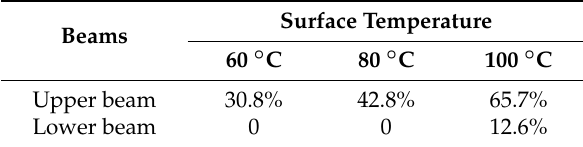
Table 2. Induction healing ratios of the samples with different surface heating